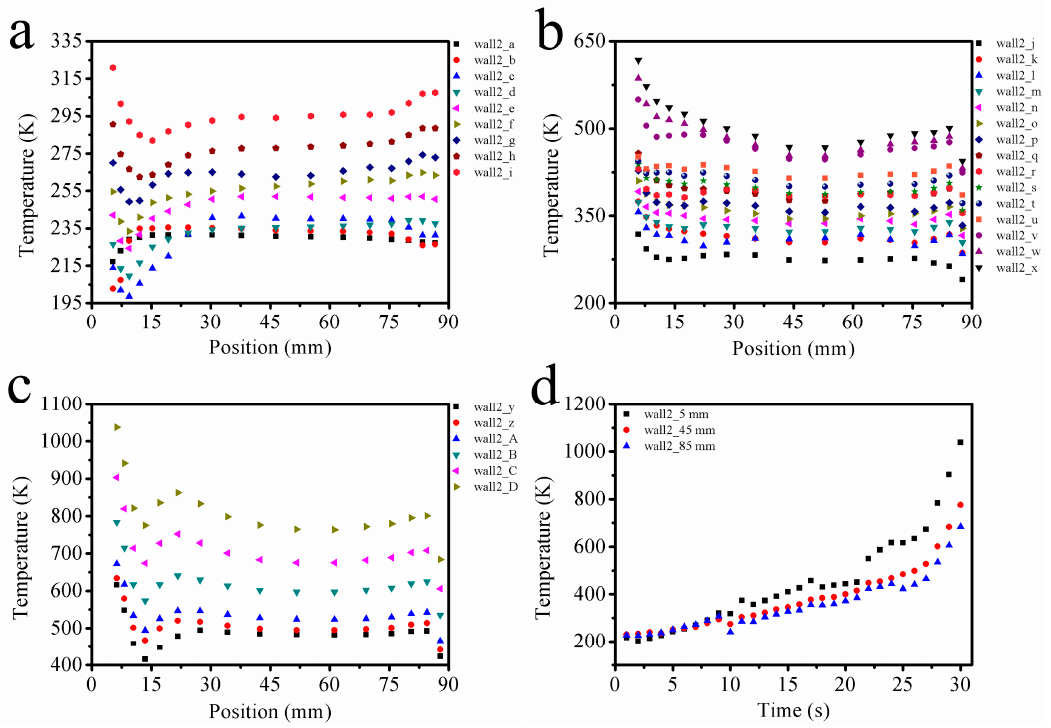
Figure 10. ( a – c ) The scatter graphs of Wall 2 between positions and temperature values and ( d ) the fitting curves. 30 groups: a–D, and each group has the same independent time interval, which is re-